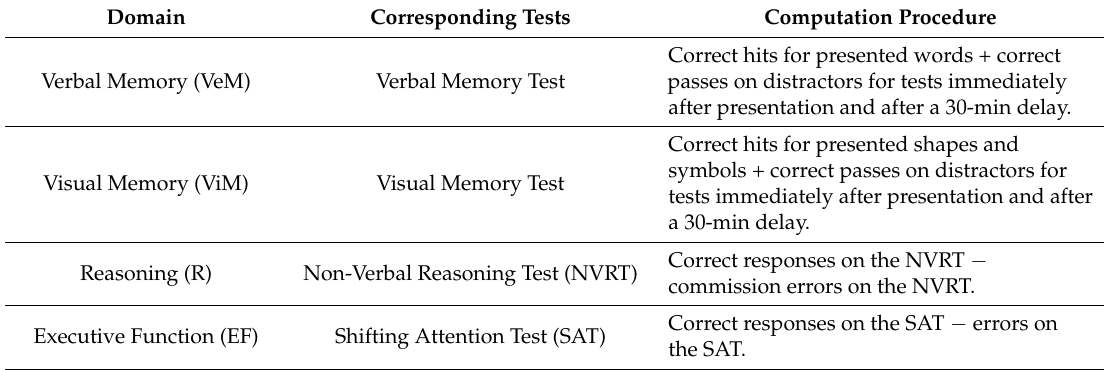
Table 2. Individual tests administered and cognitive domains evaluated in the test